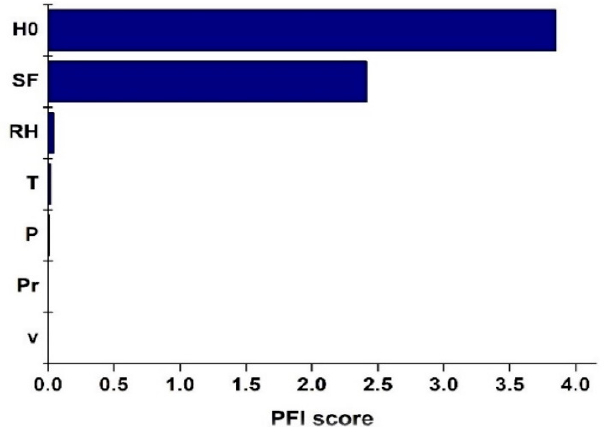
Figure 6. PFI scores of the seven studied features.